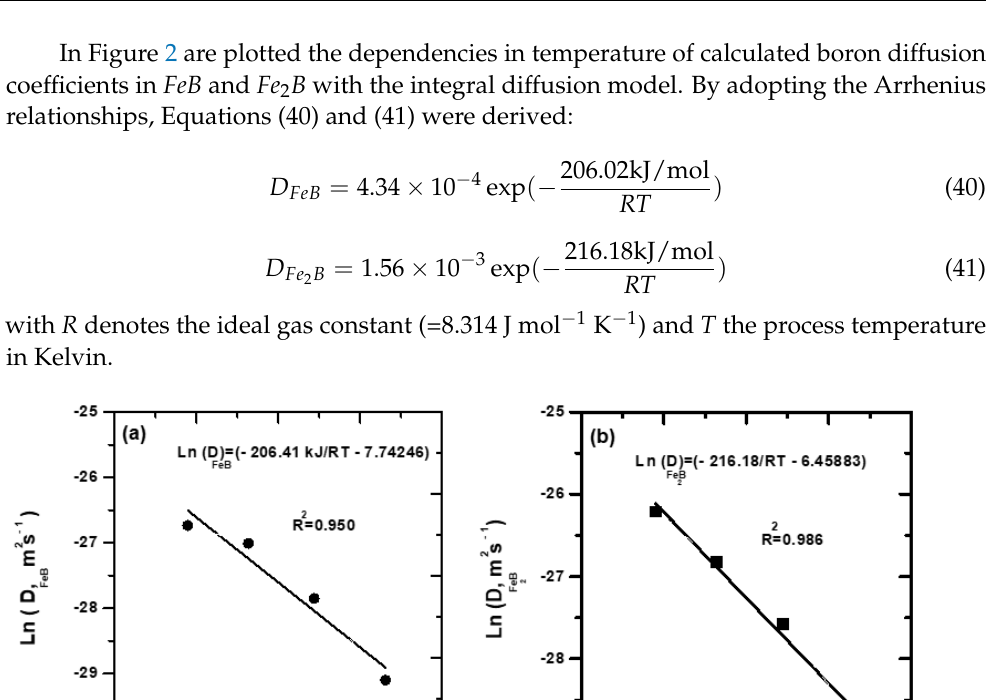
Table 3. Calculated boron diffusivities in FeB and Fe 2 B and the non-dimensional parameters with the integral method for a maximum boron content of 16.40 wt.% in FeB .